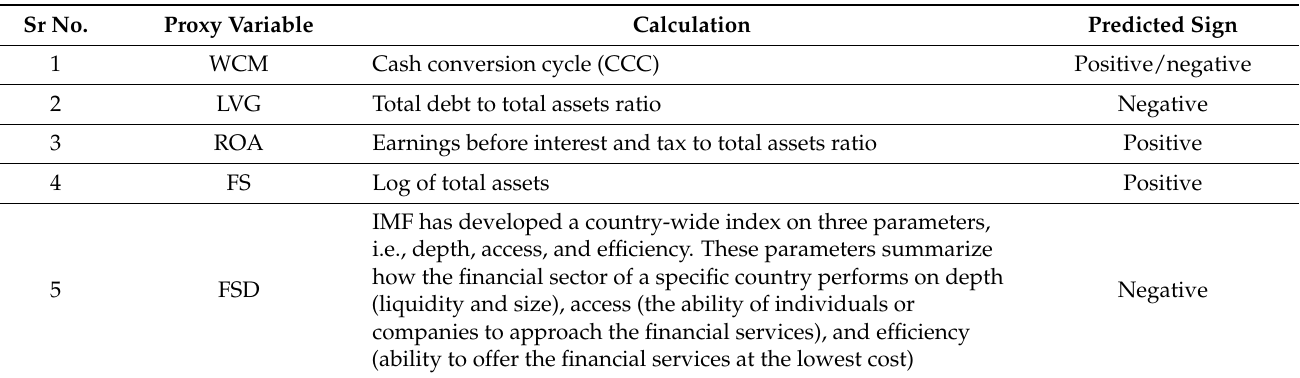
Table 2. Variable Calculation and Predicted